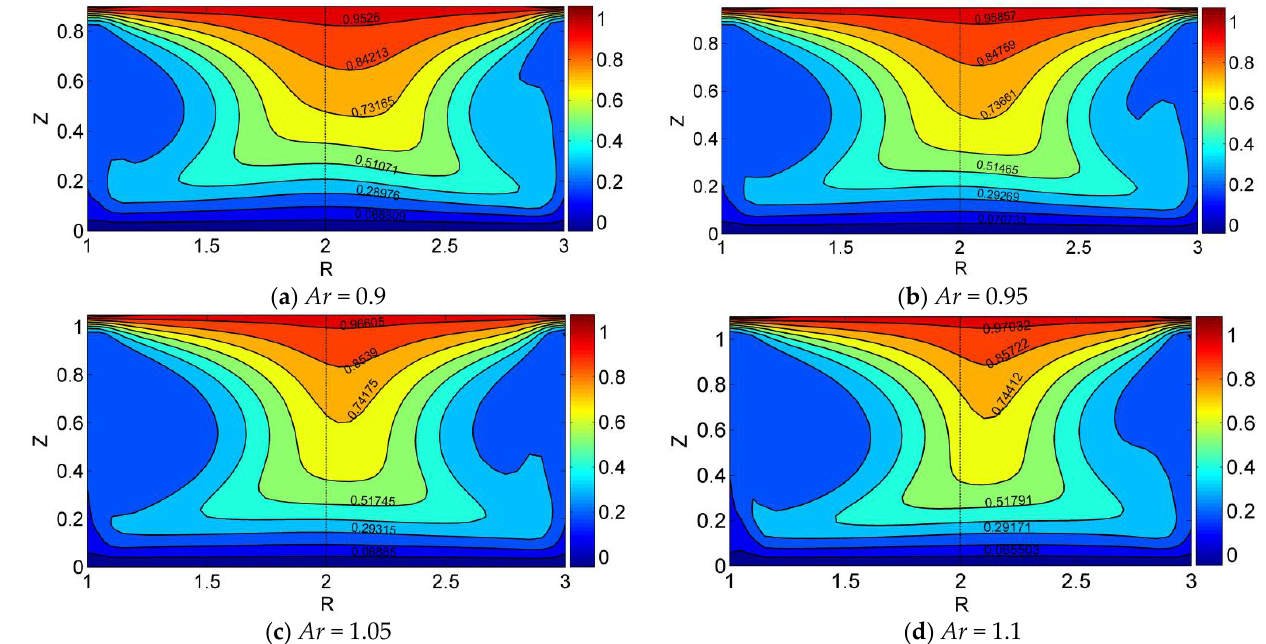
Figure 10. Concentration distribution in oscillatory stage ( Ca C = − 0.01, R = 2.5 mm, ( a ) H/R = 0.9, ( b ) H/R = 0.95, ( c ) H/R = 1.05, ( d ) H/R = 1.1, Vr = 1.0). Table 4. Layout of monitoring points in liquid bridge under different aspect